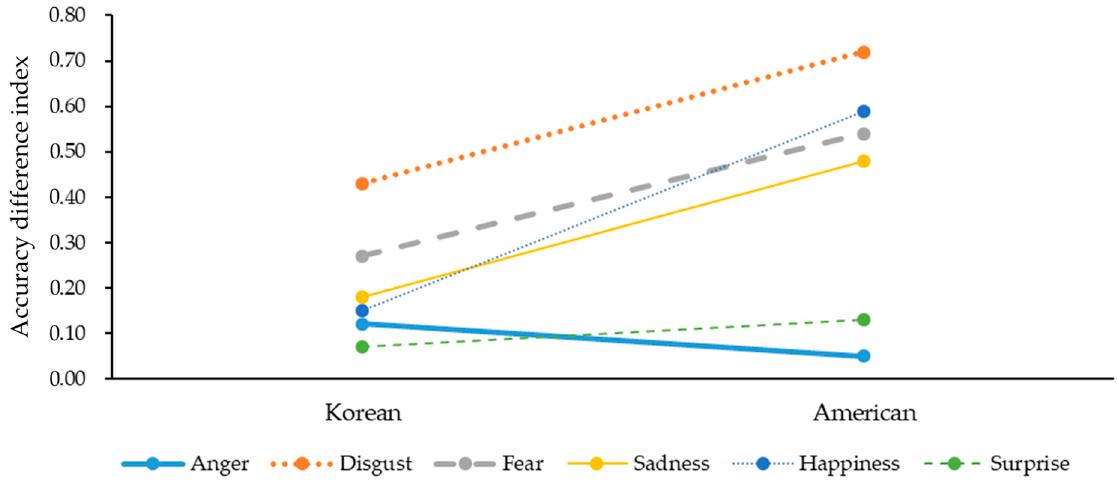
Figure 2. Graphs for participants’ nationality-related difference in accuracy difference indexes.